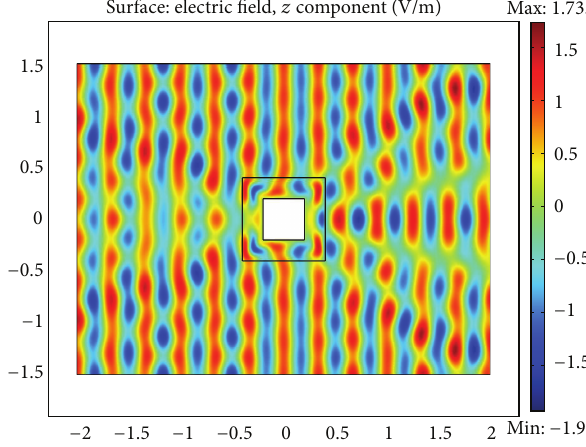
Figure 6: The coverage performance when the obstacle block the electromagnetic wave.